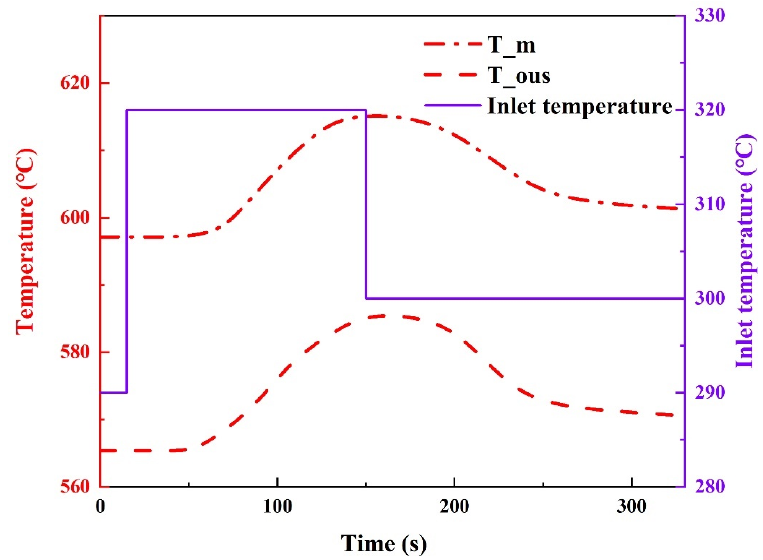
Figure 9. The results of the inlet temperature disturbance.